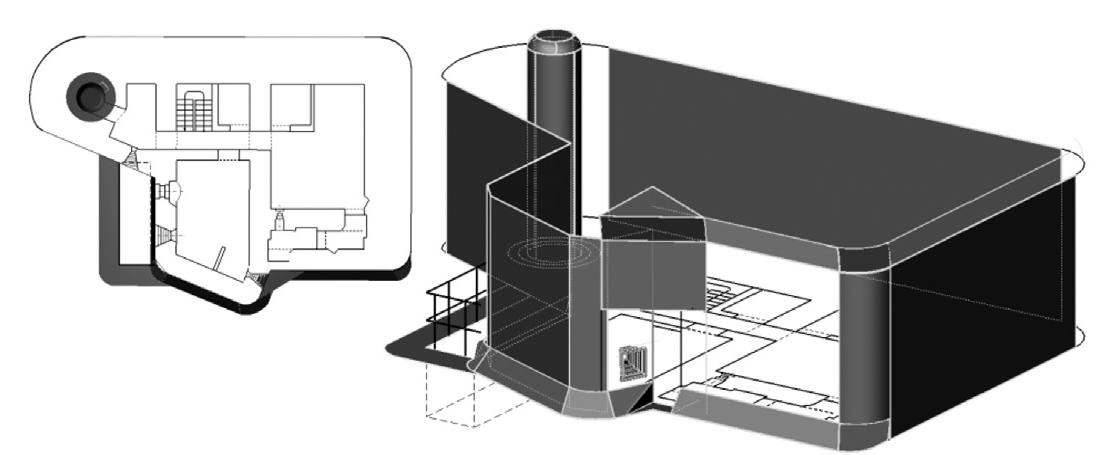
Fig. 4. 3D model MO-S